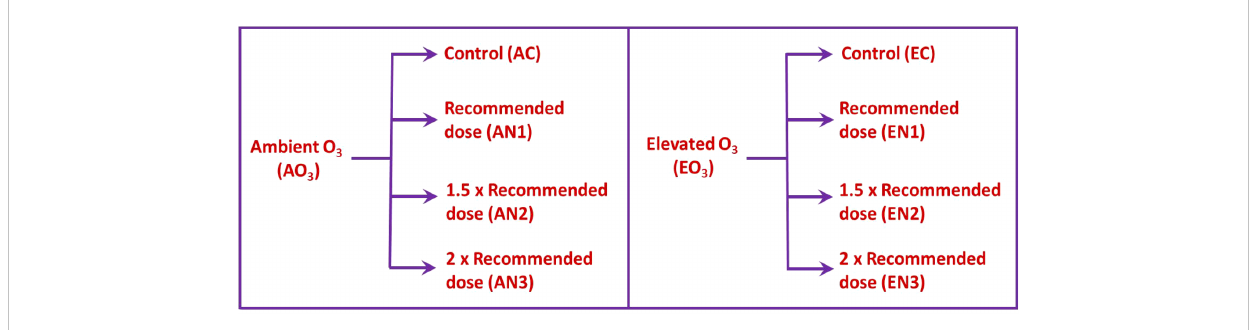
FIGURE 2 The different patterns of nitrogen amendments under ambient and elevated O 3 conditions.